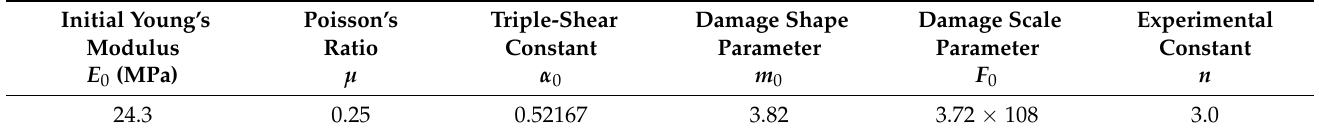
Table 1. The mechanical parameters of granite without heat treatment.